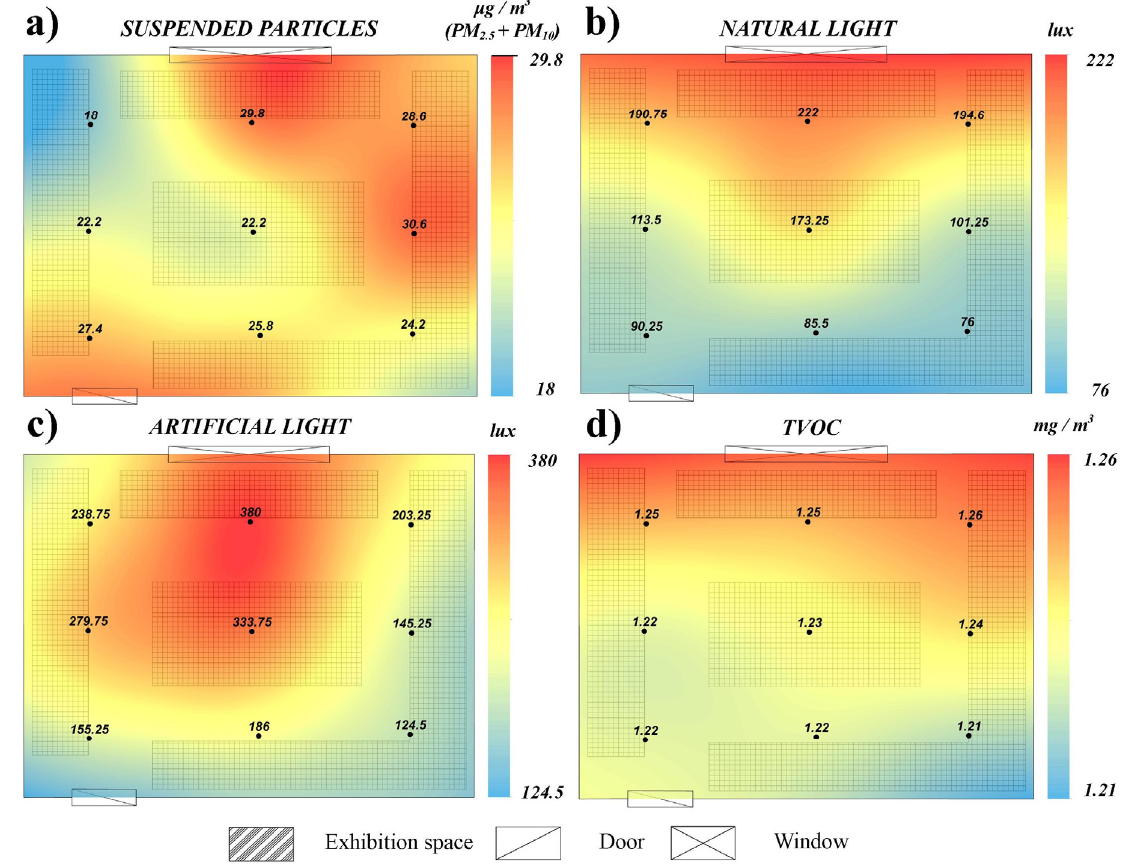
Figure 9. Distribution in space of average values for suspended particles, brightness, and TVOC ( a – d ) throughout the entire period of measurements performed in the